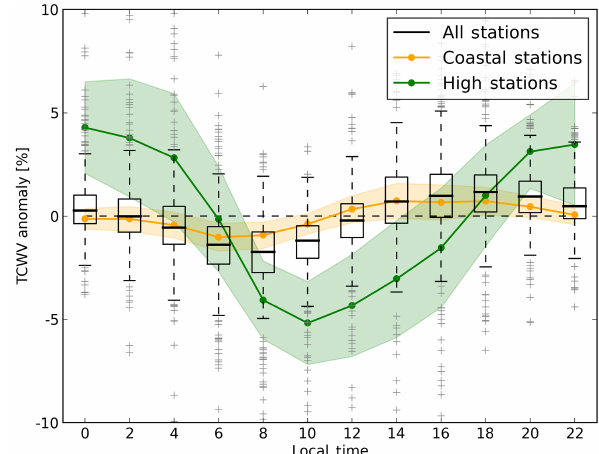
Figure 1. Global distribution and height in metres of selected GNSS stations. Note that the last height class contains all stations between 1200m and 3600m elevation.